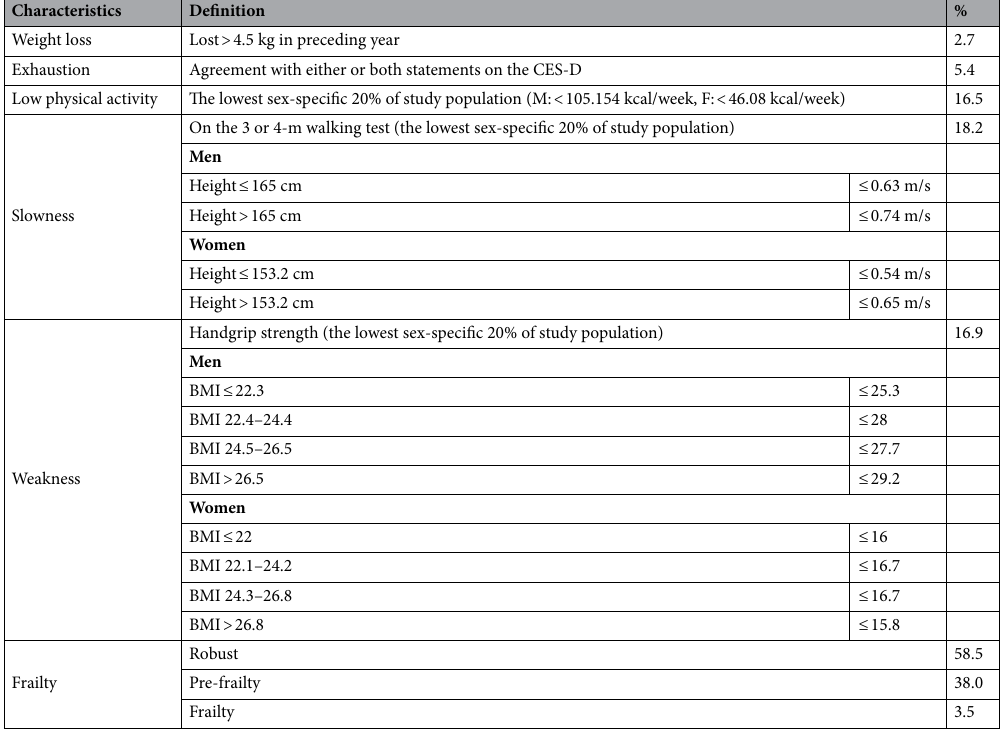
Table 4. Following the definition in Fried et al. 25 , participants without any of these foregoing conditions were considered to be either physically robust, or to have pre-frailty if they had one or two conditions, and frailty if they had three or more conditions. MMSE decline. Global cognitive function was assessed using the MMSE questionnaire at baseline and at follow-up. The MMSE score range from 0 to 30 and is commonly used in primary care and research settings with older adults. The score has been shown to be sensitive in detecting moderate-to-severe cognitive impairment 37 . The mean drop from the baseline to follow-up assessment in participants with frailty was 2.97; thus, we arbitrar- ily choose a drop of 3 or more points to be a substantial drop in cognition. Poor cognition was defined as an MMSE score below 24 38 . Given the effects of education and incomplete results, a lower cutoff was set separately for individuals with incompletion and illiteracy 38 .